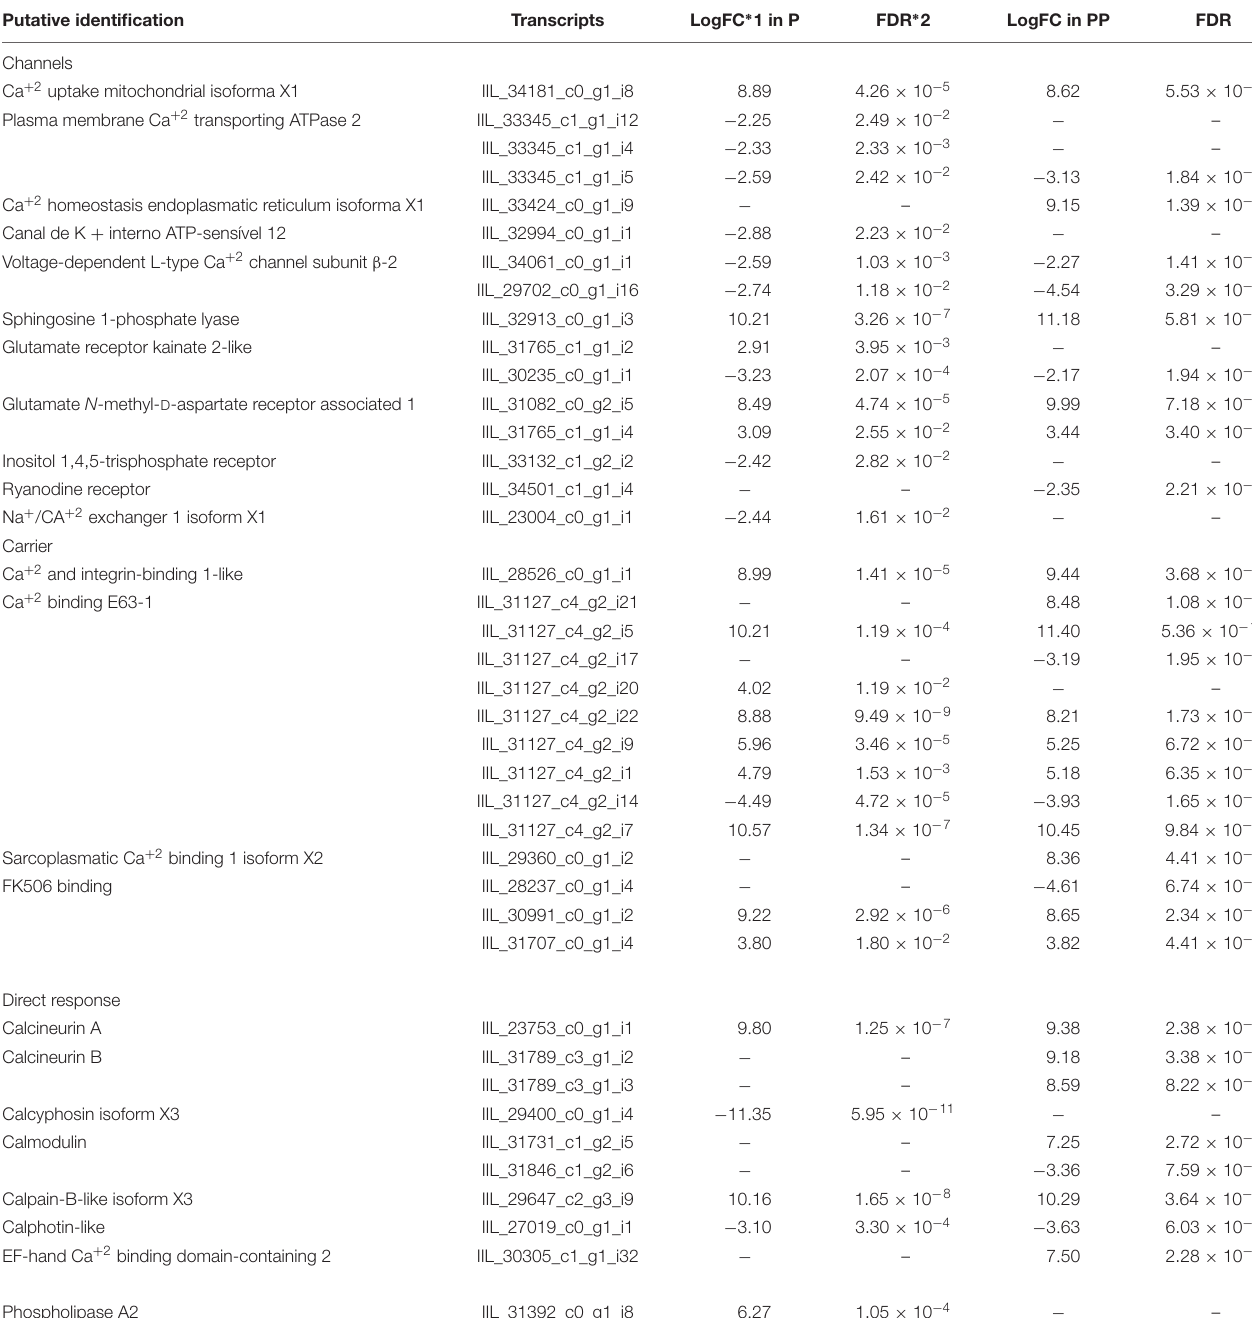
TABLE 2 | Putative identification and fold-change values of sequences related to Calcium signaling pathway in larvae of Diatraea saccharalis parasitized (P) and pseudoparasitized (PP) by Cotesia flavipes. Putative